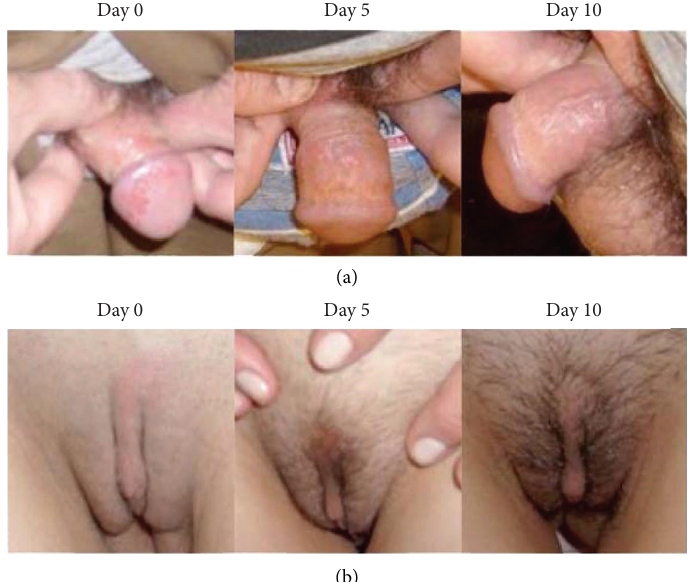
Figure 4: Visual chart for genital herpes progression. (a) 49-year-old male infected with HSV-2. (b) 46-year-old female infected with